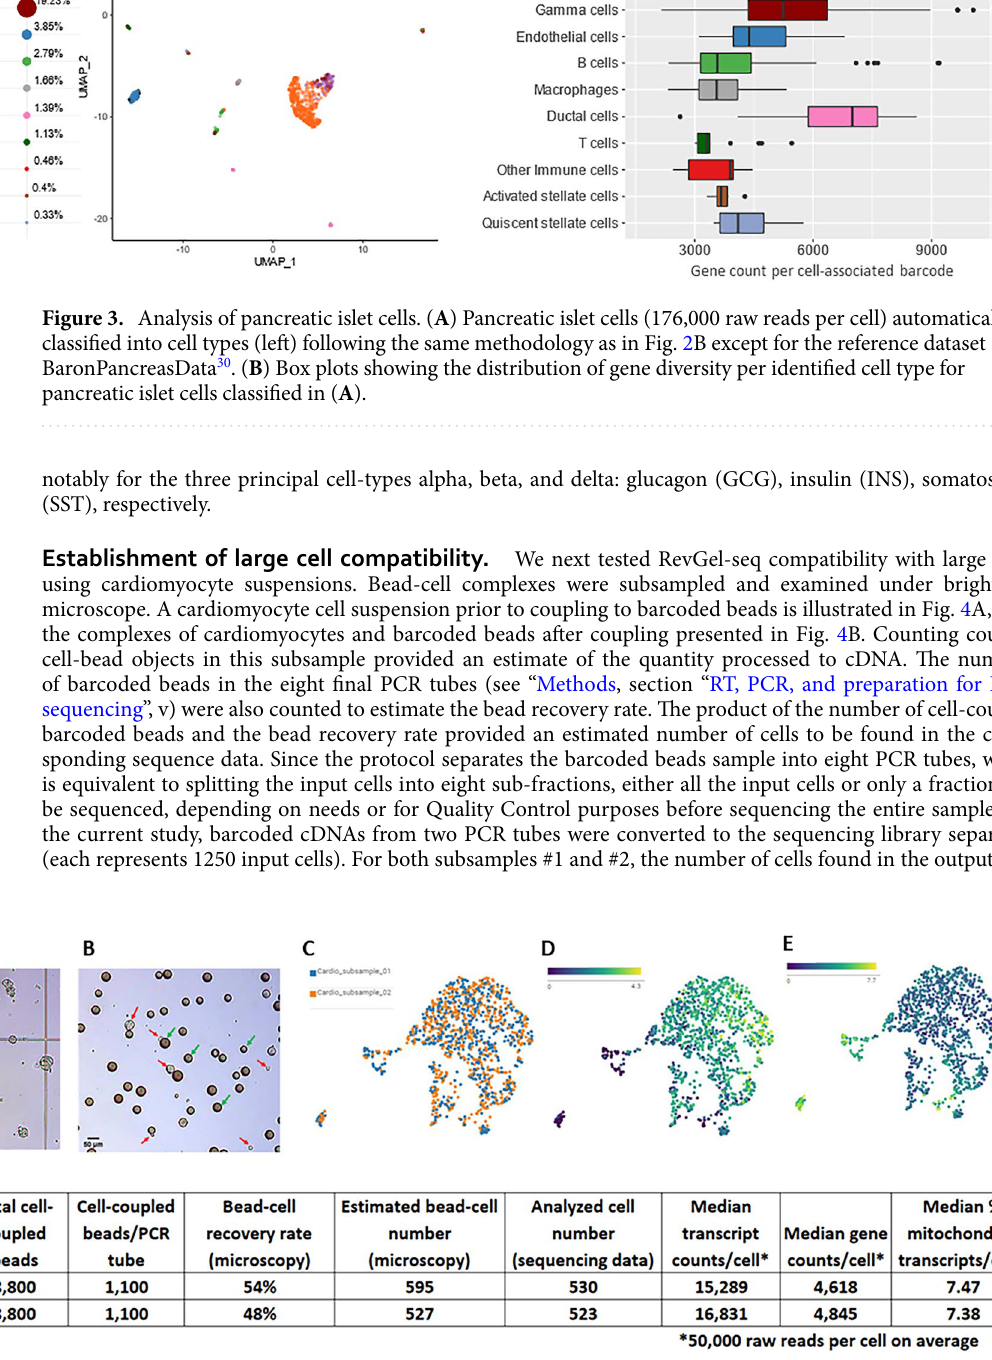
Figure 4. Evaluation of large cell processing with cardiomyocytes. ( A ) Microscopic observations of cardiomyocytes following trypsinization (cell diameter of 20–35 µm). ( B ) Microscopic observations of cardiomyocytes following coupling procedure (red arrows indicate cells, green arrows indicate beads). ( C ) 2D projections of data from two subsamples (PCR tubes) from the same cardiomyocyte sample preparation. (D) Gene expression of RYR2 (cardiomyocyte enriched gene) and ( E ) CALD1 gene expression (smooth muscle cell enriched gene). ( F ) Estimated cell quantities obtained from numbers of cell-bead complexes (for all 10,000 input cells), observed bead recovery rate (for each PCR tube, max 12.5% for each of 8 PCR tubes), and transcript/ gene counts per analyzed cell at average 50,000 raw reads per cell. Sequencing data was processed according to Methods, section “RevGel-seq sample preparation workflow” by the pre-processing analysis pipeline of Cytonaut, which automatically detects the analyzed